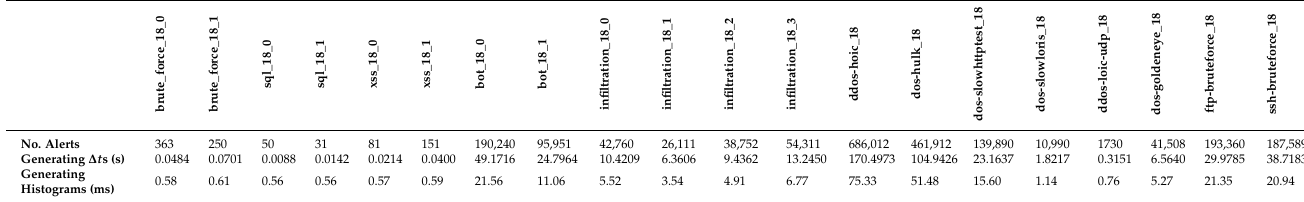
Table 9. Average processing time to generate sig temp for a selection of attack scenarios of